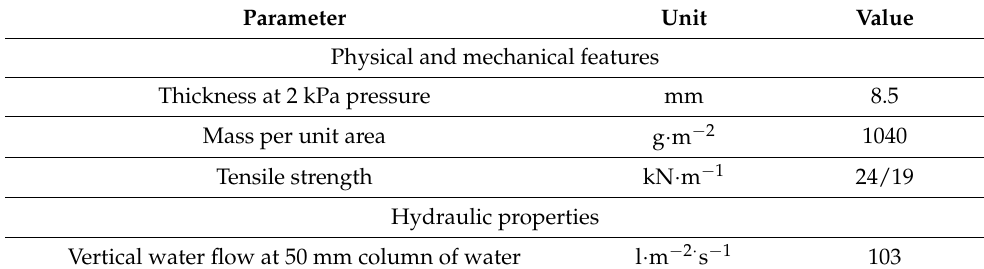
Table 1. General technical characteristics of the drainage geocomposite Pozidrain